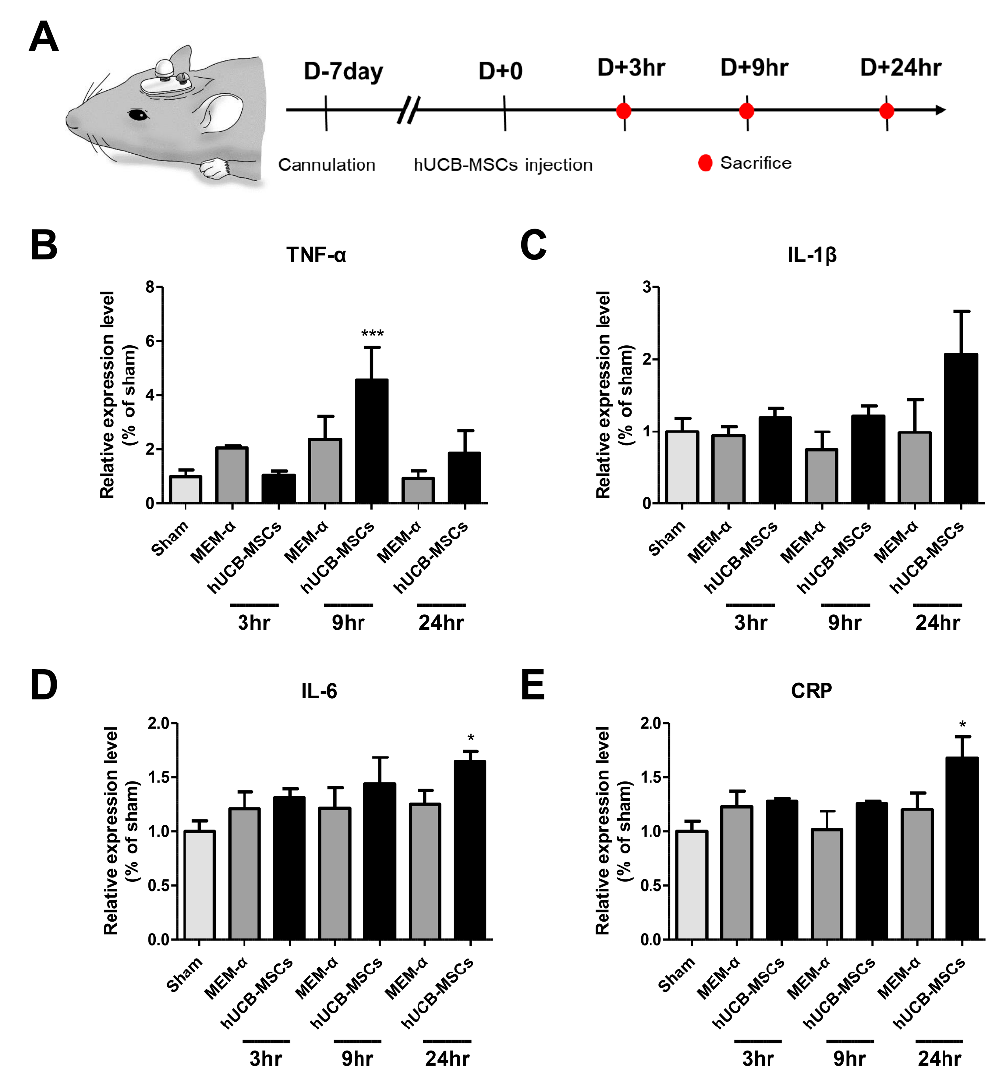
Figure 2. Pro-inflammatory cytokine levels increased in 5xFAD mice following hUCB-MSCs admin- istration. ( A ) Mouse experiment timeline. ( B ) TNF- α , ( C ) IL-1 β , ( D ) IL-6, and ( E ) CRP expression levels were analyzed at three different time points: 3, 9, and 24h after hUCB-MSC administration. TNF- α expression levels increased 9 h after hUCB-MSCs administration and IL-1 β , IL-6 and CRP expression levels increased 24 h after hUCB-MSC administration (* p < 0.05, *** p < 0.00001). The data are presented as mean ± S.E.M (average of three independent experiments).